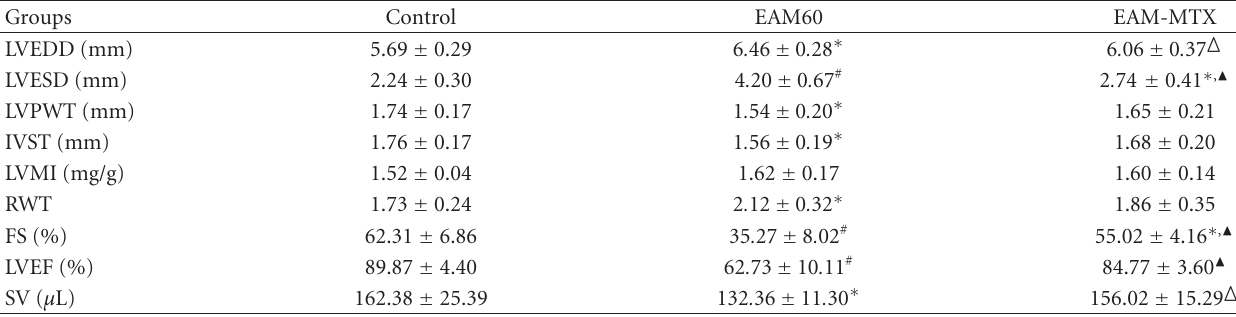
Groups Control EAM60 EAM-MTX LVEDD (mm) 5.69 ±